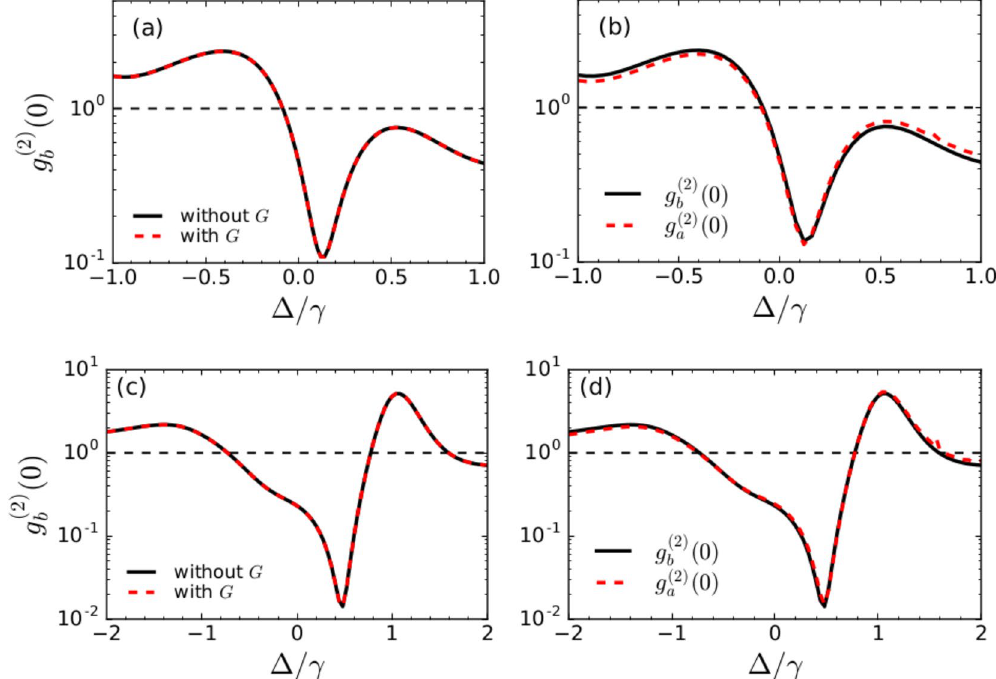
Figure 8. ( a ) The phonon correlations when the drive is applied only on the primary resonator i.e. Ω 2 = 0, (2) in absence of the optomechanical coupling (black solid line) and in presence of optomechanical showing g (0) b coupling (red dashed line). ( b ) The phonon and photon correlations calculated for the total Hamiltonian in (2) in absence of the optomechanical coupling (black solid presence of the optomechanical coupling. ( c ) g (0) b line) and in presence of optomechanical coupling (red dashed line) for additional driving of the secondary mode. ( d ) The phonon and photon correlations with two drives in presence of the optomechanical coupling. Other parameters are κ = 10 γ , G = 0.1 κ . The dashed black lines correspond to g (2) (0) =